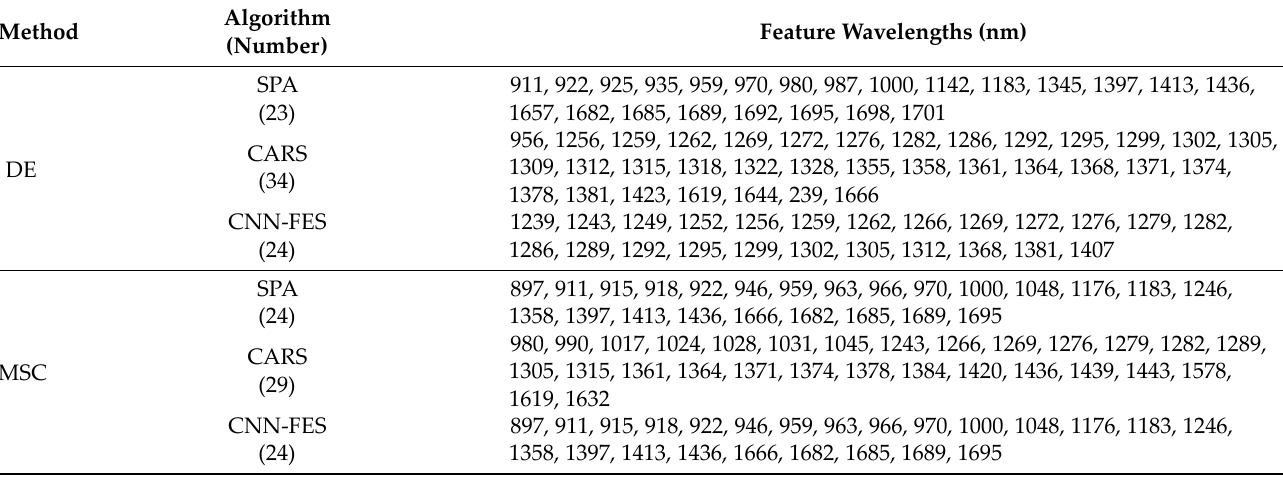
Figure 11. CNN-FES network selected feature wavelengths: ( A ) the value of IS of each feature wavelength; ( B ) the selected wavelength variables. Table 1. Feature wavelengths selected by different